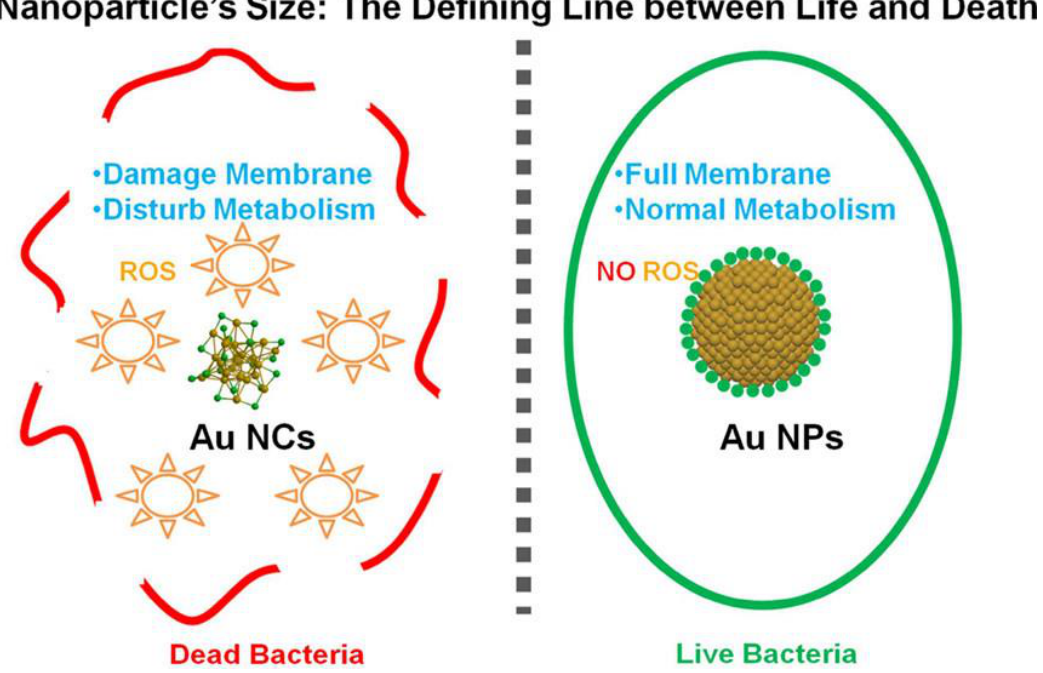
Figure 1. Antimicrobial activity of MHA-AuNCs due to the increase of interaction between MHA-AuNCs and bacteria. Reproduced with permission from Reference [71]. Copyright © 2017, American Chemical Society.